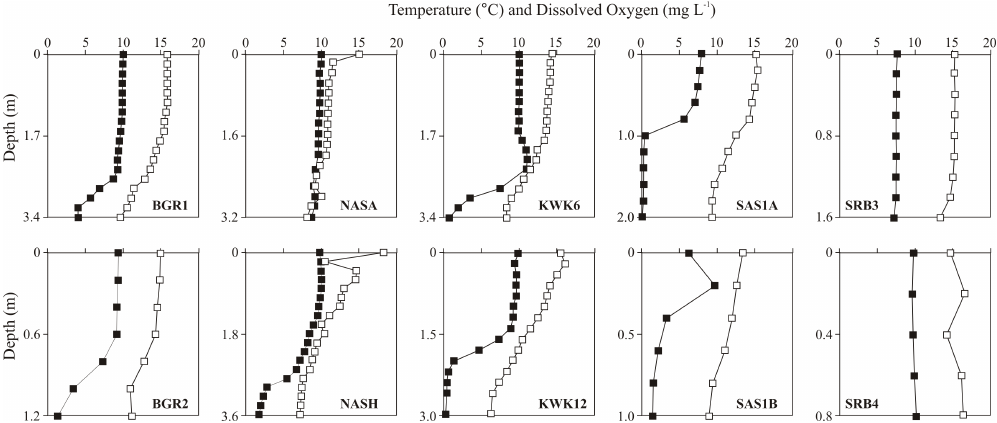
Figure 2. Temperature (white squares) and oxygen (black squares) stratification in the permafrost thaw lakes (BGR, KWK, NAS, SAS) and shallow rock-basin lakes (SRB) in summer 2012. The codes at the bottom of each graph refer to specific